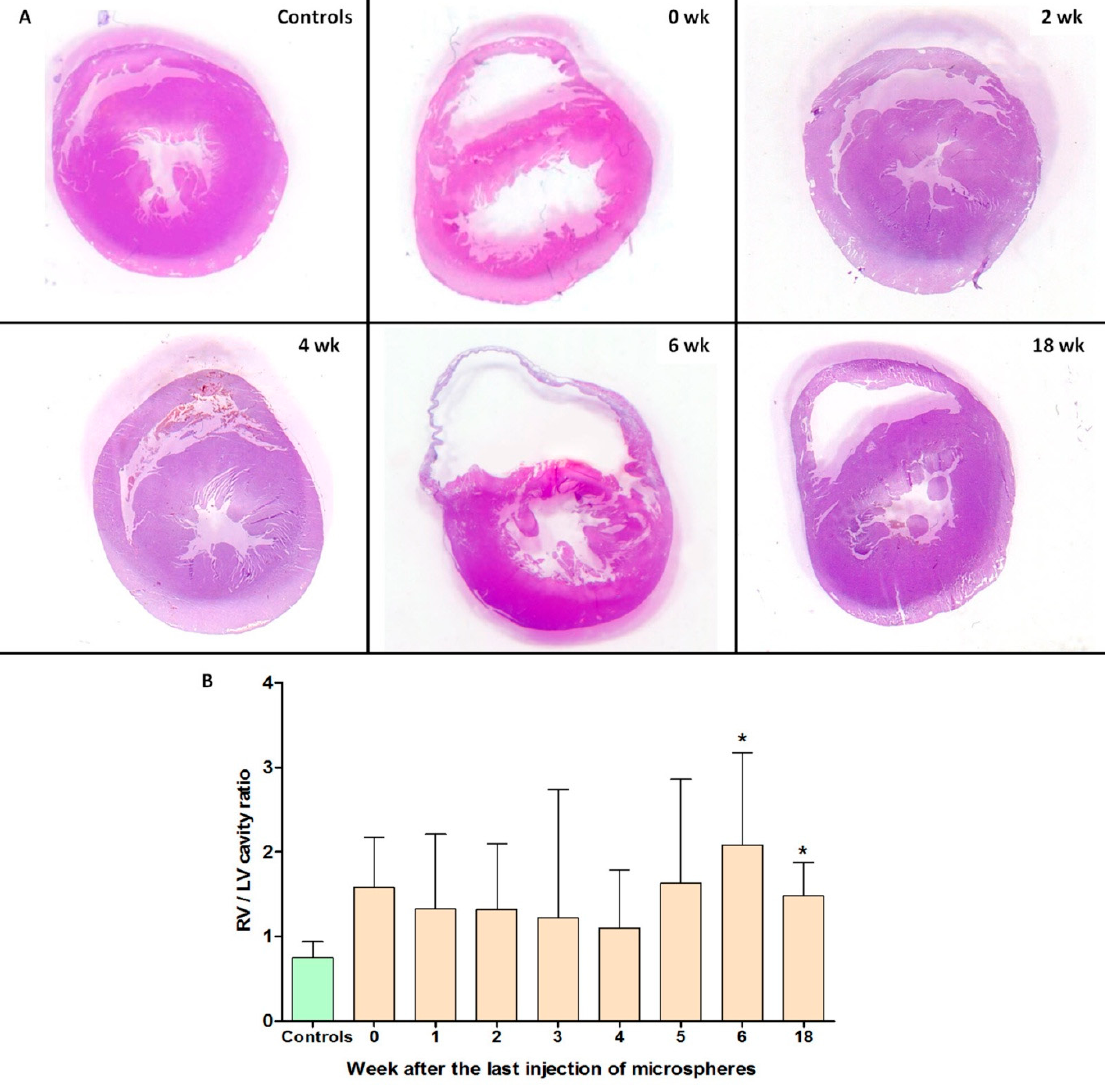
Figure 5. Histological heart examination. ( A ) Hematoxylin–eosin-stained representative cross-sections of the heart at different times after embolization. ( B ) The ratio of the right ventricle (RV) cavity area to the LV cavity area. * p < 0.05 in comparison with the control group. n = 7 at each time point in CTEPH group.